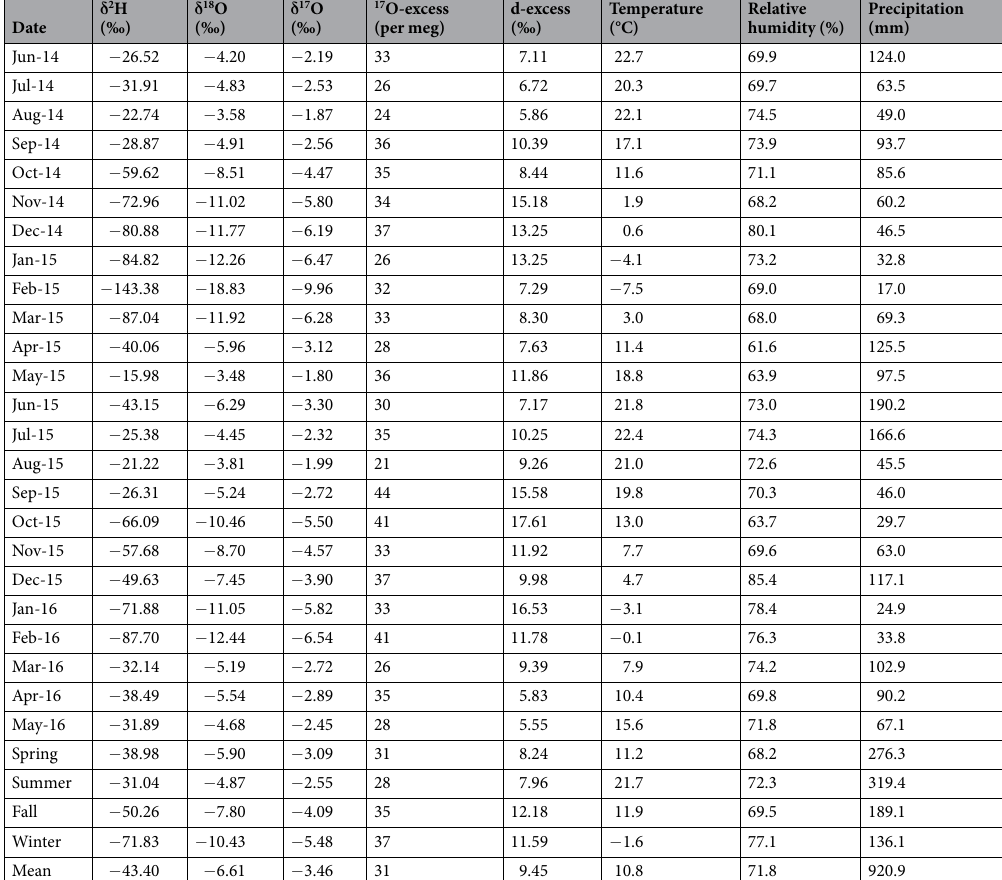
Table 1. Monthly amount-weighted mean values of δ 2 H, δ 18 O, δ 17 O, 17 O-excess and d-excess as well as monthly average temperature, relative humidity and total precipitation in central Indiana (June 2014-May